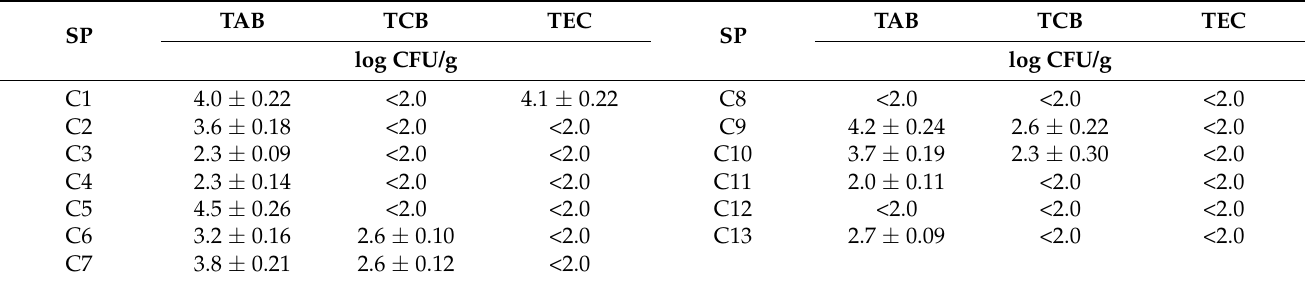
Table 6. Number of total aerobic bacteria, coliform bacteria, and enterococci in samples of